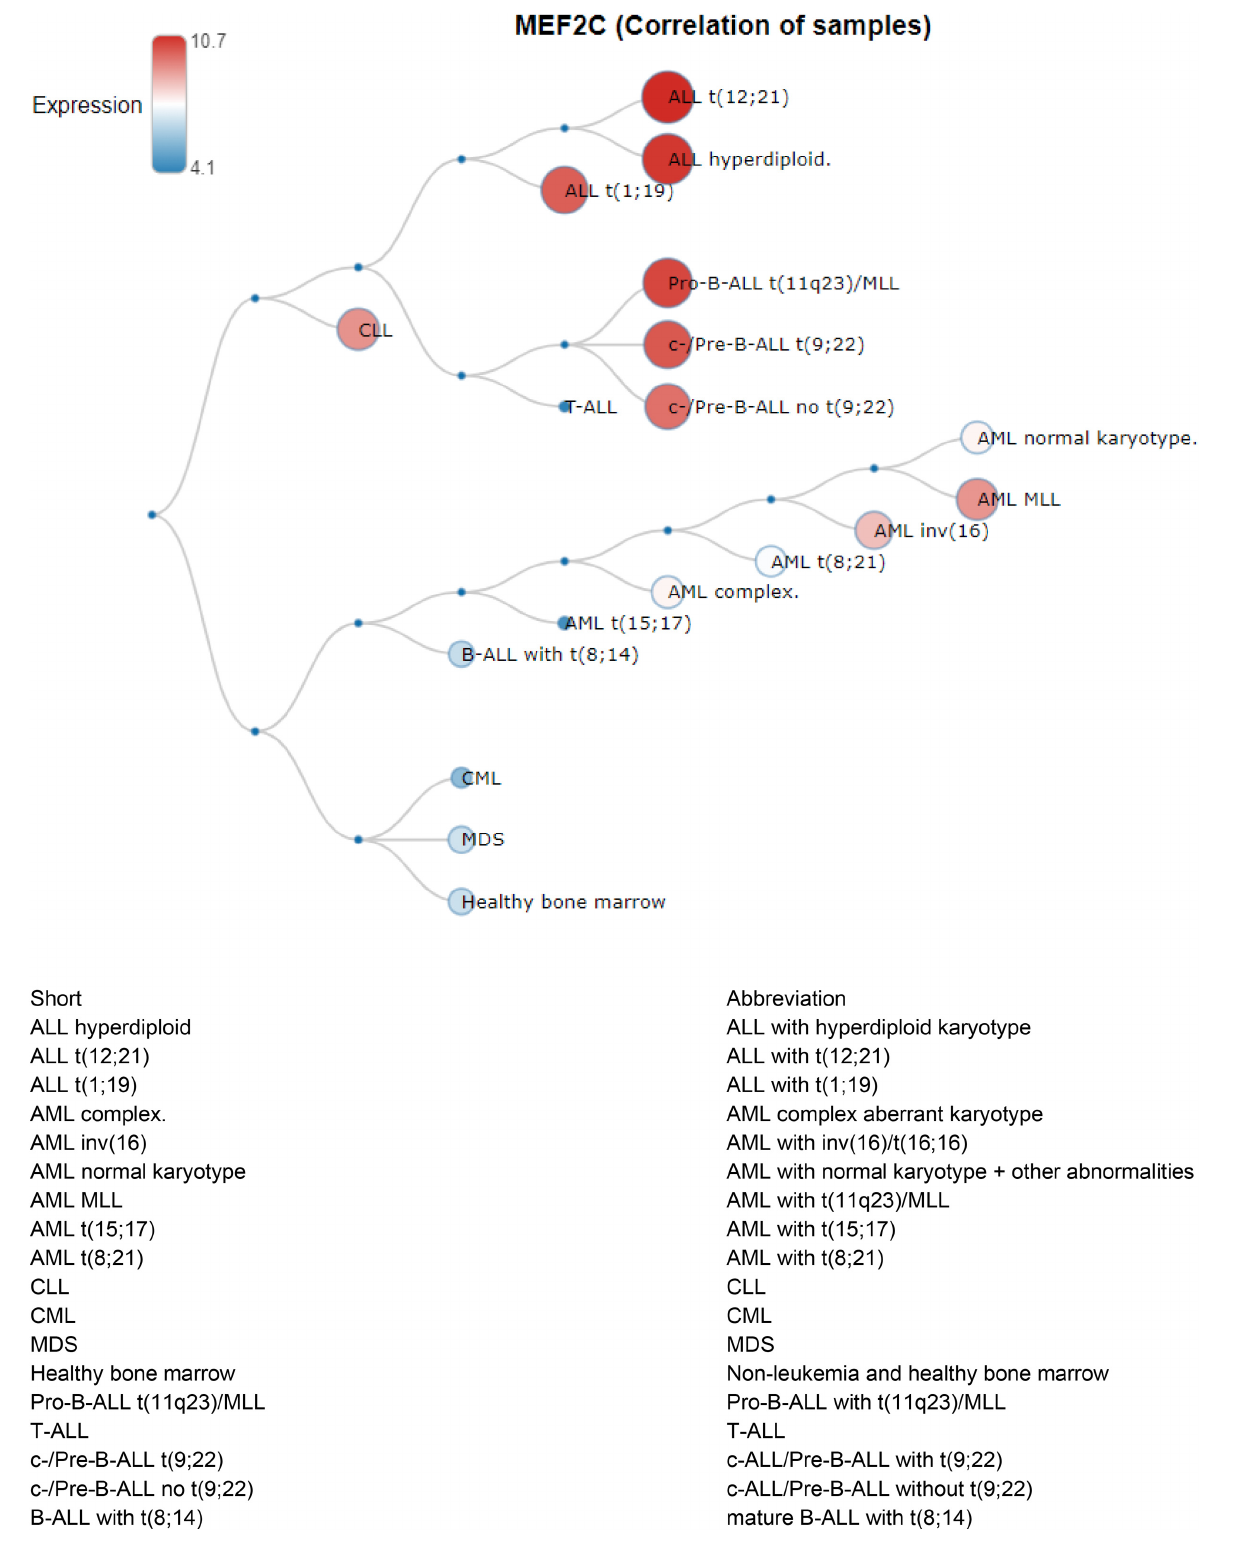
Frontiers in Cell and Developmental Biology |